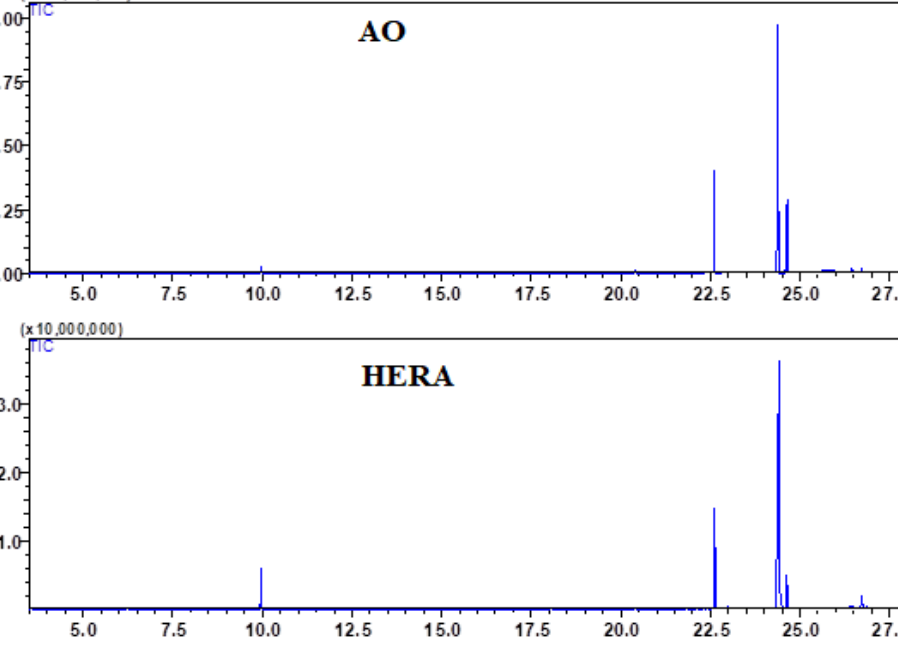
Figure 1. GC-MS chromatogram of AO and HERA. Table 1. Chemical composition of AO and HERA.